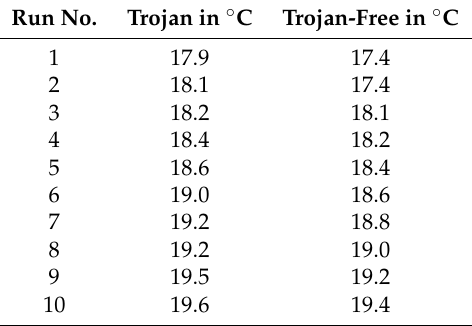
Table 3. Infrared thermometer results. Run